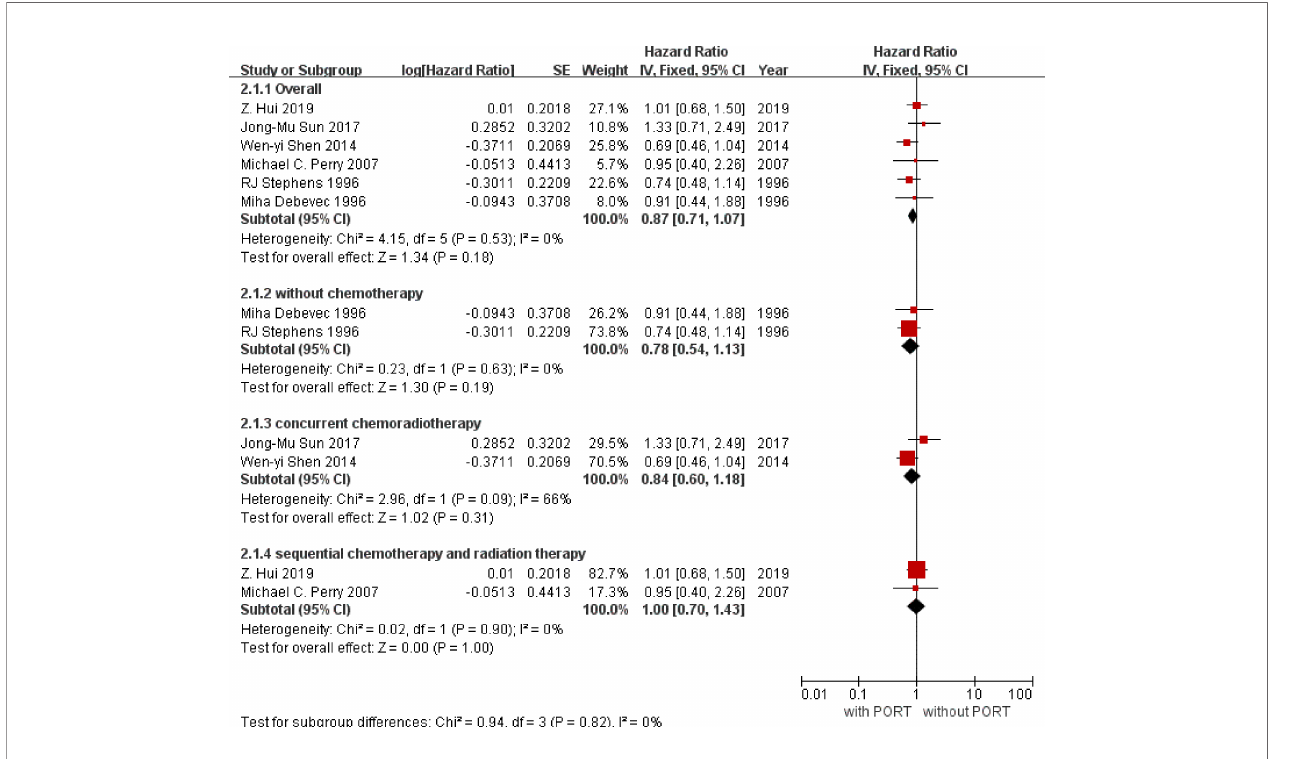
FIGURE 3 | Overall survival. PORT, post-operative radiotherapy; HR, Hazard Ratio.